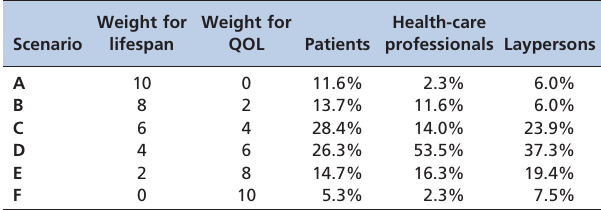
Table 5 - Prioritization between survival time and quality of life (QOL) using